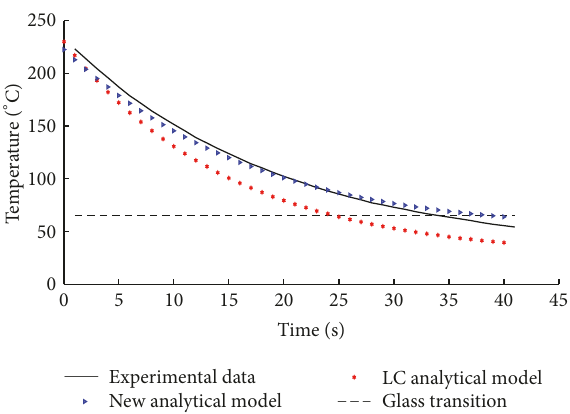
Figure 11: Experimental profiles compared with analytical